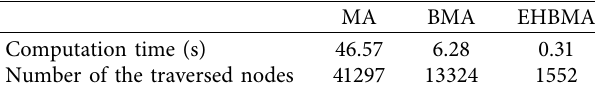
Table 4: Performance comparison of MA, BMA, and EHBMA.